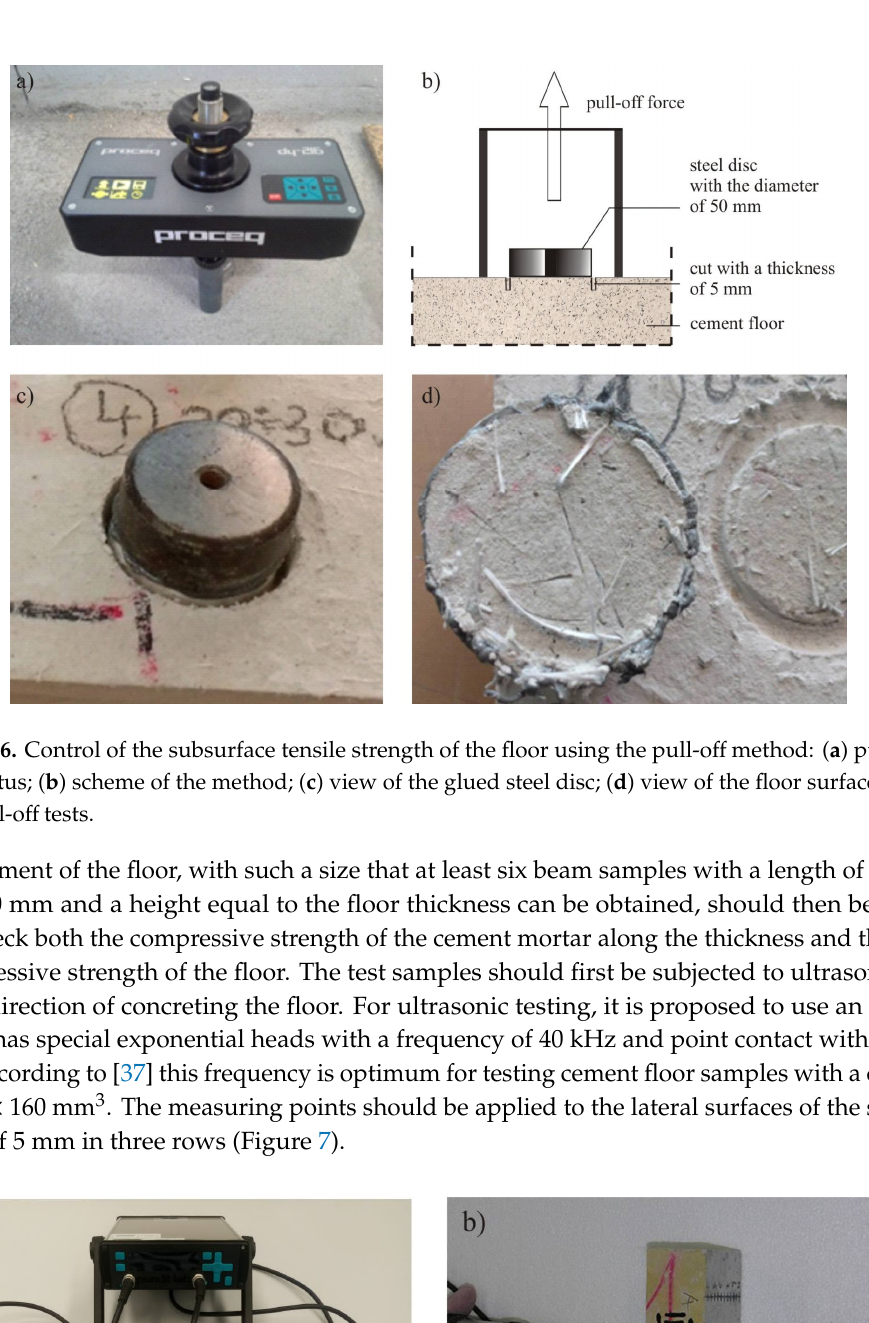
Figure 5. Methodology of controlling the technological process of executing floors made of cement-based materials—Stage 3 (control strength tests after finishing the execution of the floor).